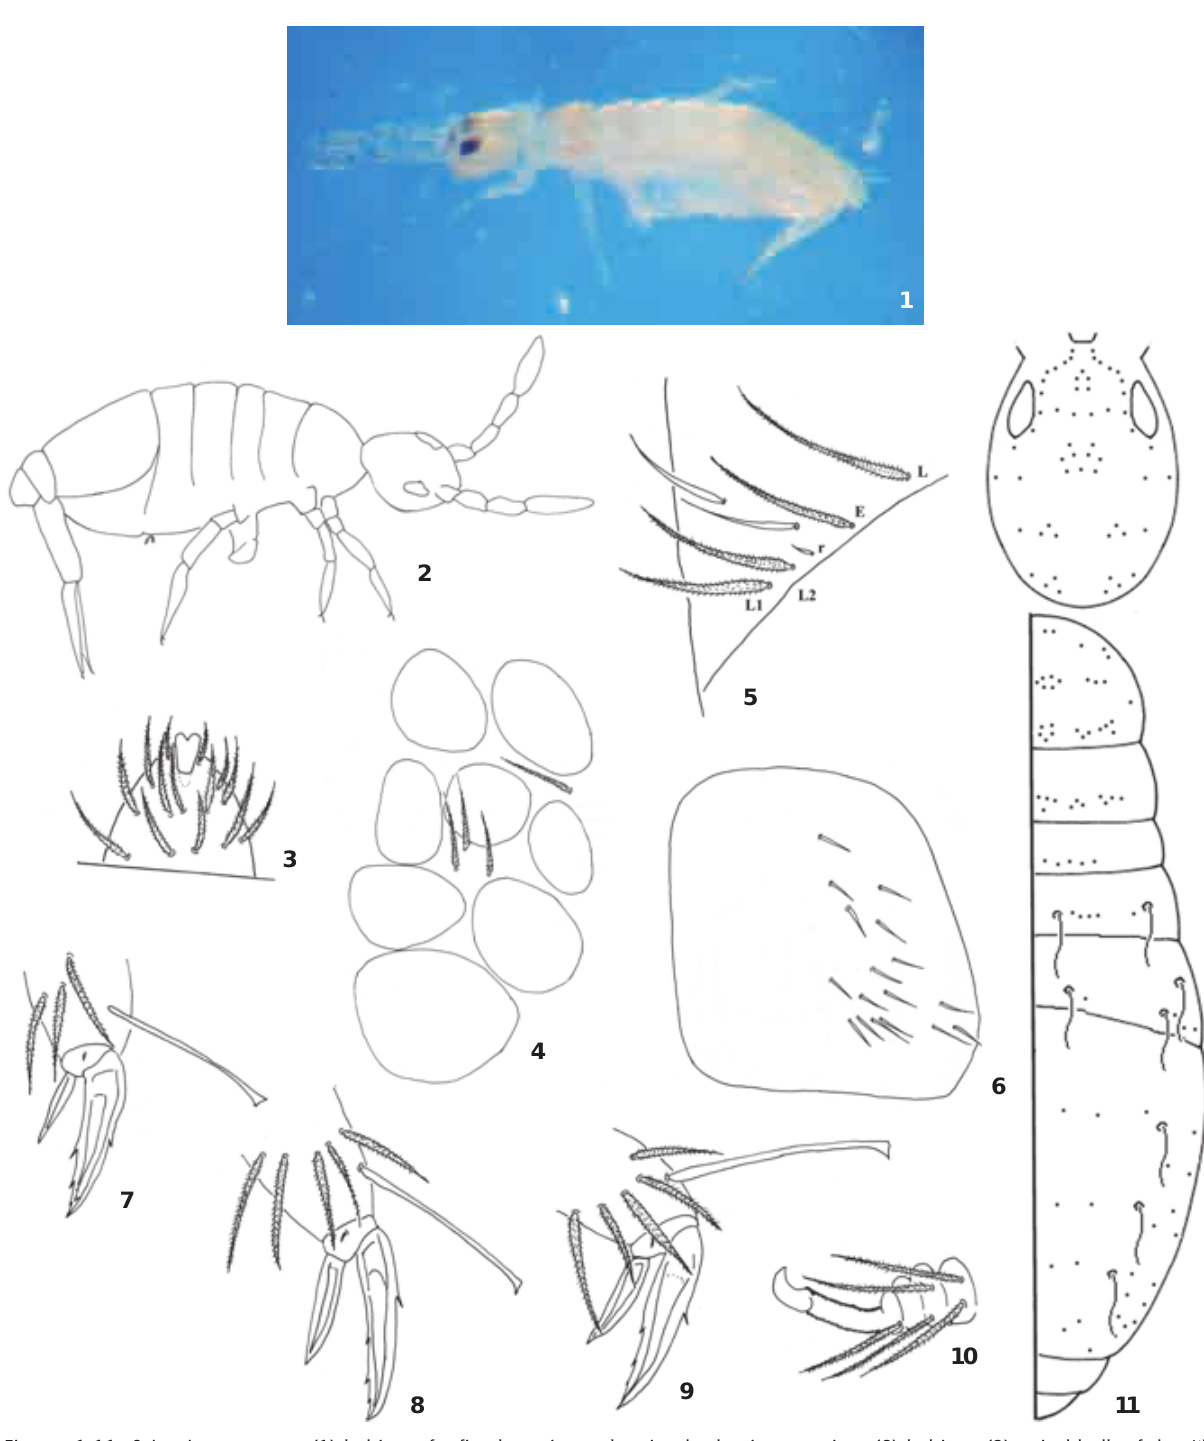
Figures 1-11. Seira ritae sp. nov. : (1) habitus of a fixed specimen showing body pigmentation; (2) habitus; (3) apical bulb of the 4 th antennal segment; (4) lenses of the right eyepatch; (5) setae of the labial triangle; (6) trochanteral organ; (7) first foot complex; (8) second foot complex; (9) third foot complex; (10) distal dens and mucro; (11) dorsal macrochaetae